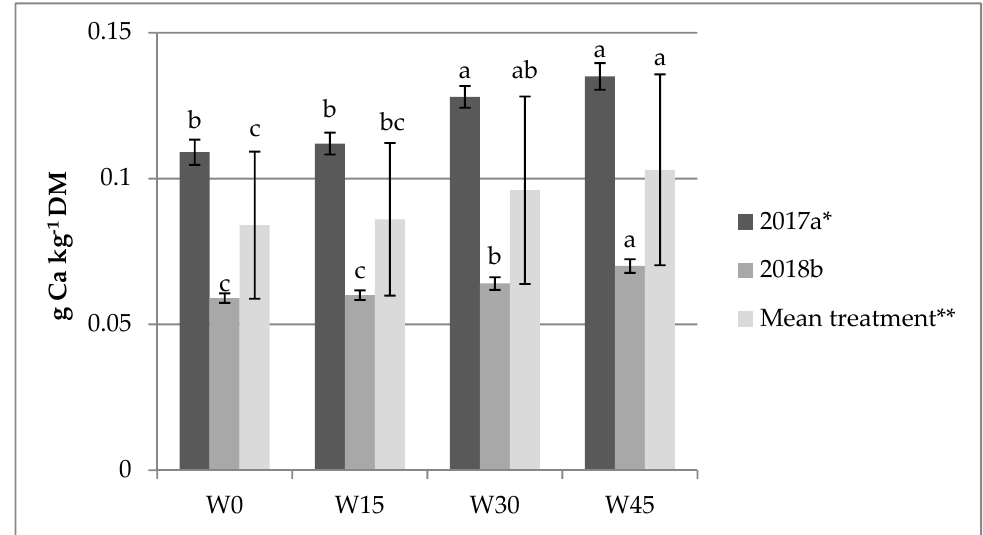
Figure 3. Phosphorus content in maize grain. W0—the control with no stillage treatment, W15—15 m 3 of stillage per hectare, W30—30 m 3 of stillage per hectare, W45—45 m 3 of stillage per hectare. * means of years regardless of treatments; ** means of treatments regardless of years. The same letter means not significantly di ff erent.